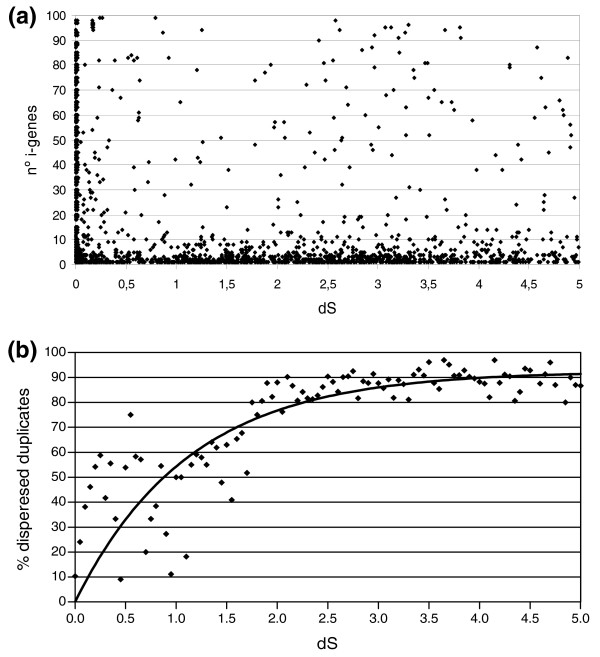
Genomic and temporal distribution of duplicated genes in D. melanogaster. (a) The distance between duplicates does not increase sequentially with time, as estimated by dS values. The majority of gene pairs are either very near or far apart. The most frequent profiles for duplicated genes are (but not restricted to) consecutive (i-genes approximately 0) or recently (dS approximately 0) duplicated genes or both. Only pairs separated by up to 100 intervening genes and with dS < 5 are shown. (b) The proportion of pairs of duplicated genes that have separated increases over time, reaching a point where more than 90% of all duplicated genes are not physically linked. For example, there are 240 linked pairs in the dS 0-0.5 range, while there are only 19 for dS 4.5-5.0. The best fit exponential distribution that reaches a plateau at 92.51% is shown as a solid line.